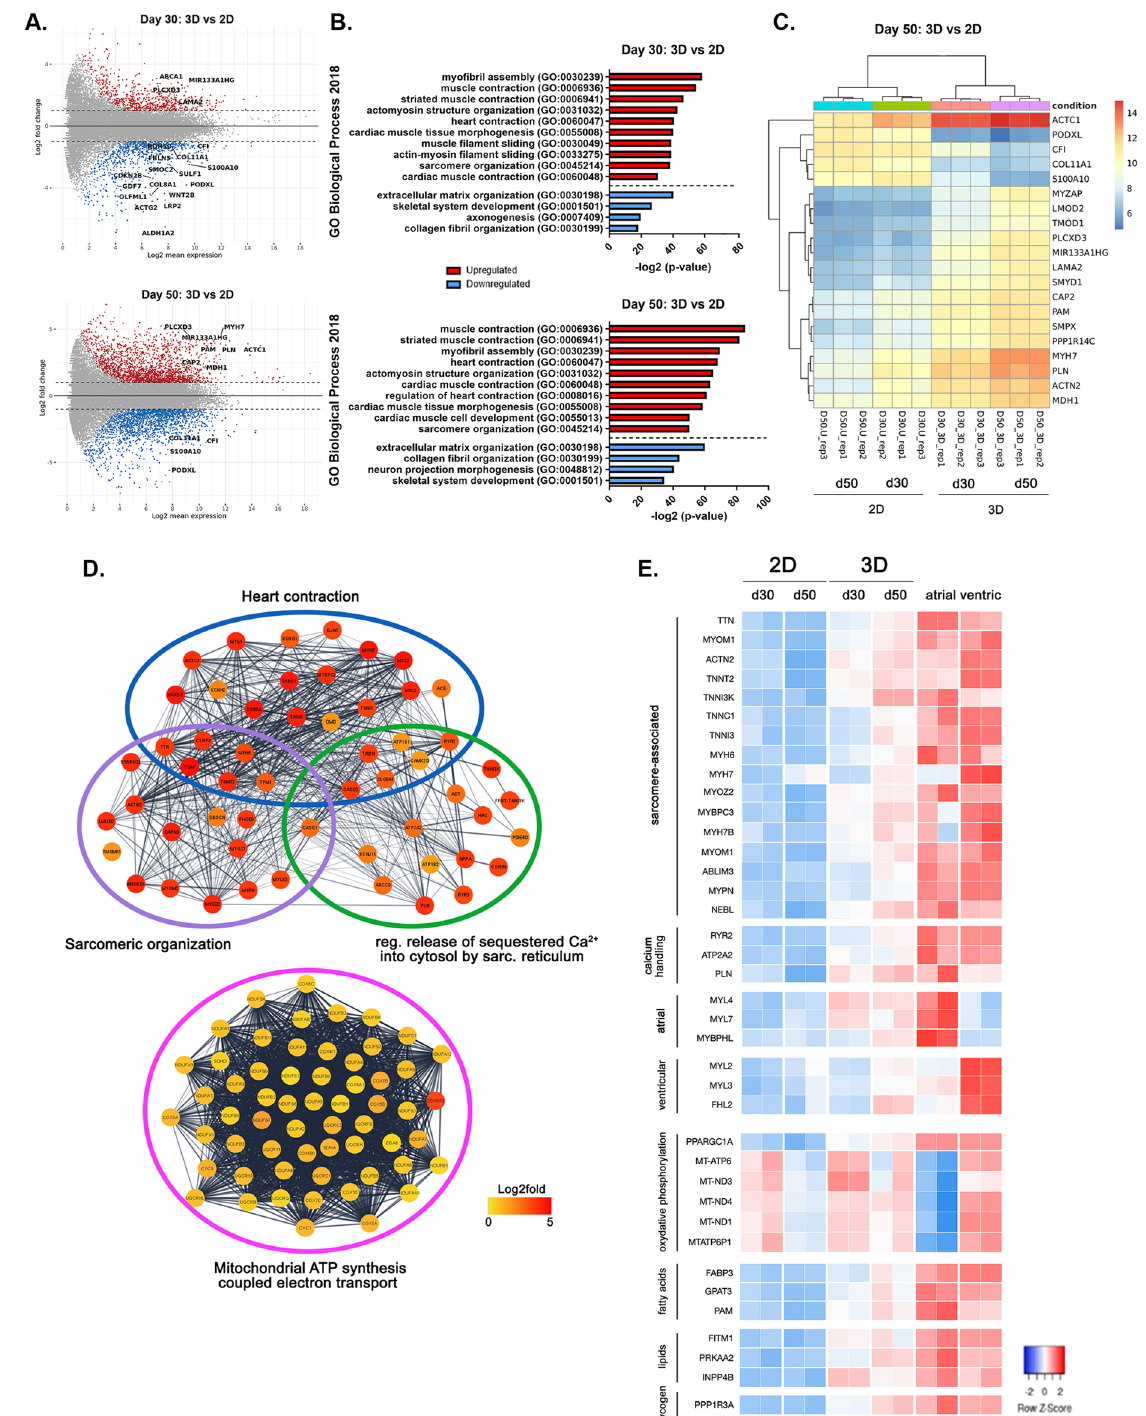
Figure 6. 3D long-term cultures induce improved cardiac specification and cardiomyocyte maturation at transcriptional level. ( A ) MA plot of the differentially regulated genes between 2D monolayer and 3D hOCMTs at day 30 (up) and day 50 (down) (log2 mean, p.adj < 0.05). ( B ) Graph representing the − log2value adjusted p-value of significantly upregulated (red) or downregulated (blue) GO Biological process categories when comparing 3D hOCMTs and 2D monolayers at day 30 (up) and day 50 (down) (p.adj < 0.05). ( C ) Heatmap representing the log2fold change for the top 20 differentially regulated genes between 2D monolayer and 3D hOCMTs at day 50 (p.adj < 0.05). ( D ) STRING network of the upregulated genes at day 50 hOCMTs as compared to monolayer cultures for the indicated GO biological processes categories by Cytoscape (Kappa score = 0.3). Log2fold change for the nodes (genes) is represented using a color-coded scale. ( E ) Heatmap encoding for log2fold changes in selected cardiac genes for the 3D hOCMTs and the 2D monolayers at both time-points in comparison with available datasets for adult human atrial and ventricular tissues (p.adj <